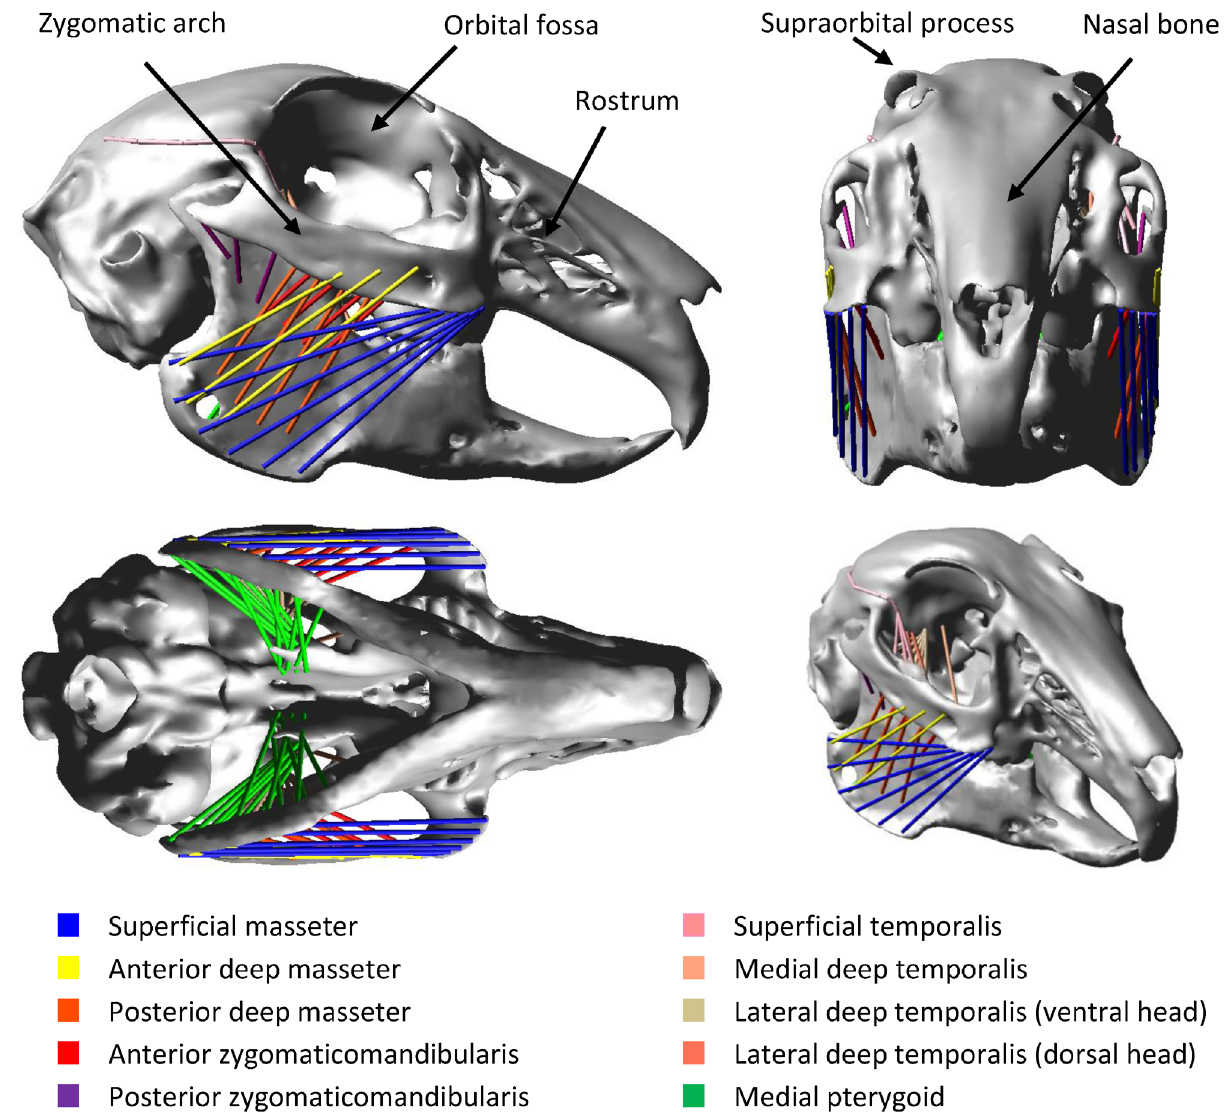
Figure 1. The multi-body dynamics model of the rabbit skull showing the strands used to represent the masseter, zygomaticomandibularis, temporalis and pterygoid muscles. The lateral pterygoid was also included in the model, but is not visible in the depicted